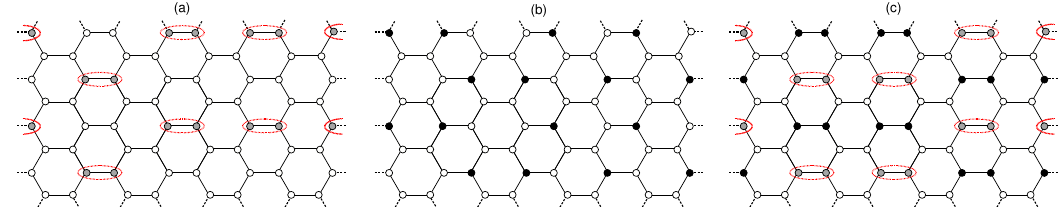
Figure 12: Pictorial description of the insulating structures corresponding to the density-plateaus in Fig. 11 c at (a) ρ = 1 / 8, (b) ρ = 1 / 4, and (c) ρ = 3 /